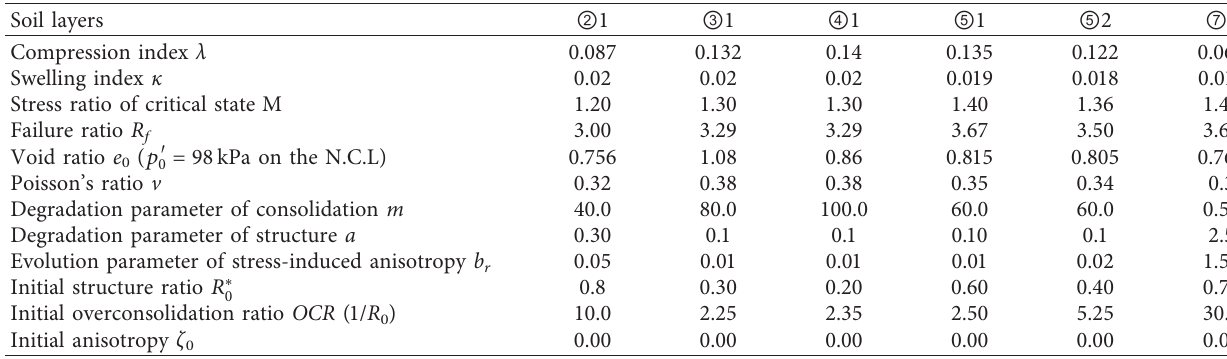
Figure 23: Diagram of train vibration load on the track bed. Table 9: Parameters of soft soil layers [34].